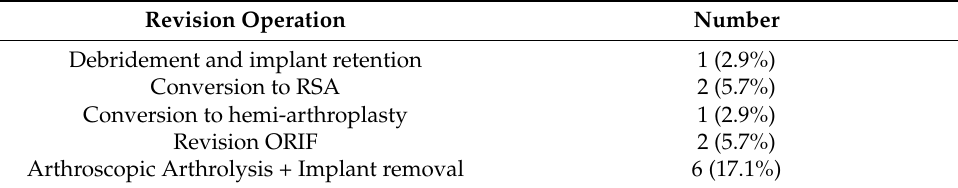
Table 4. Revision